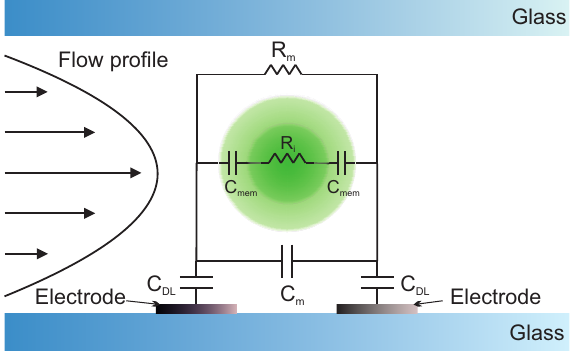
Figure 12. Equivalent electrical circuit of a phytoplankton cell in a microfluidic channel. R m and C m are the resistance and capacitance of the medium, respectively, C mem is the capacitance of the cell membrane, R i is the resistance of the cell cytoplasm and C DL the capacitance of the electrical double layer (DL). The values of the individual electrical components are determined by the dielectric properties of the suspending medium, the geometry of the chip and the dielectric properties of an individual cell